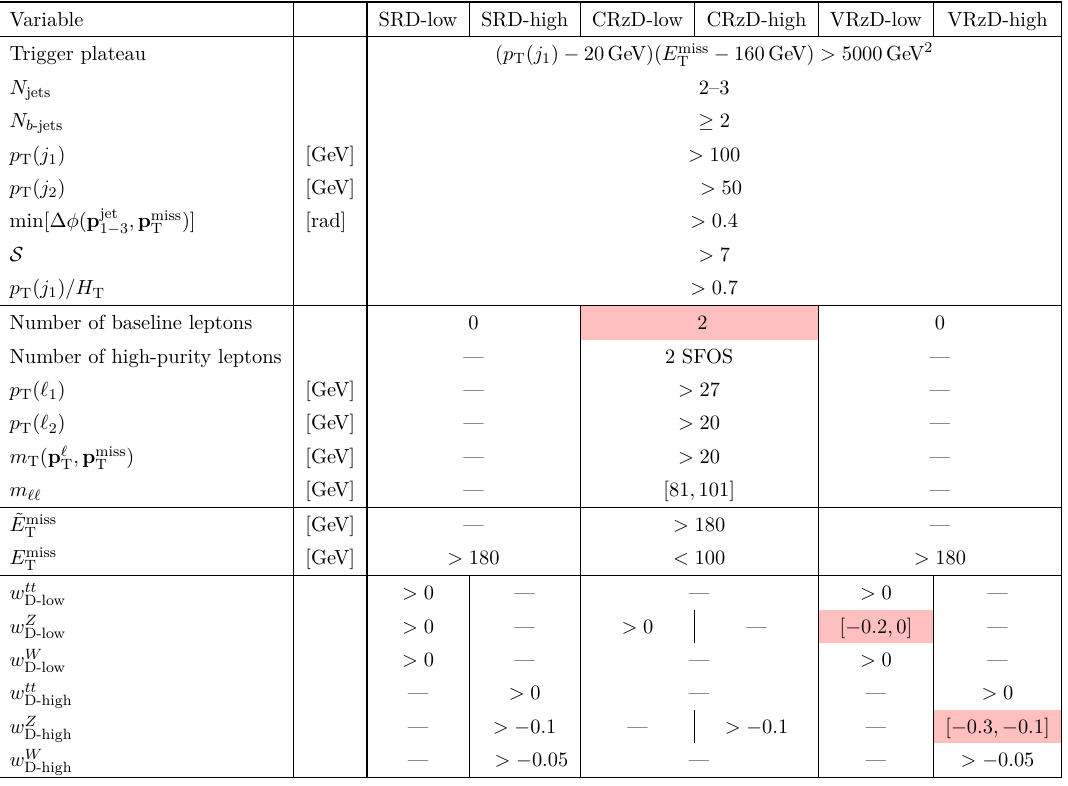
Table 5 . SRD signal, control and validation region definitions. Pink cells for the control and validation regions’ columns indicate which selections ensure that they are orthogonal to the corre- sponding